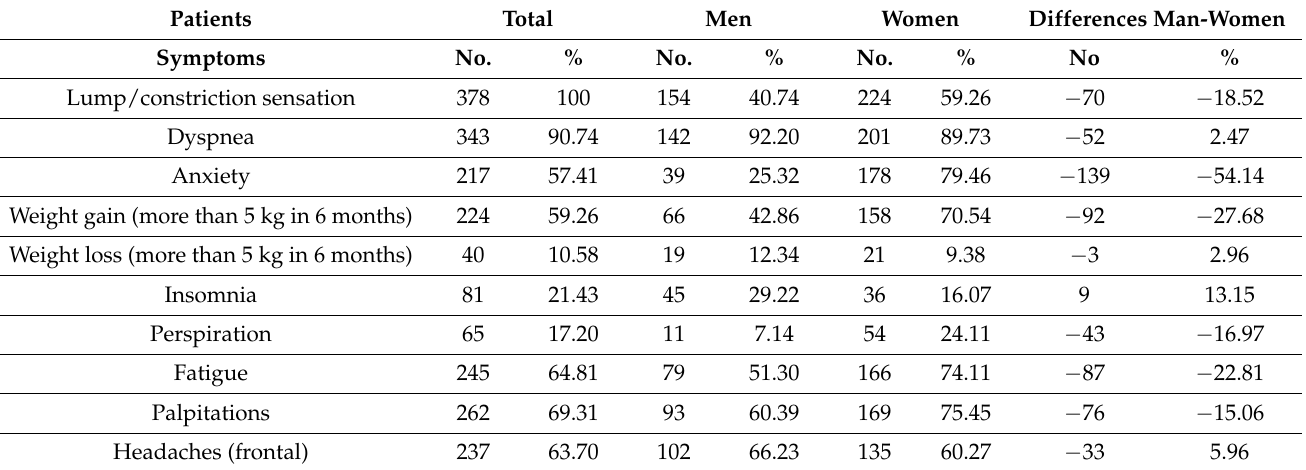
Table 2. Patients’ symptomatology.